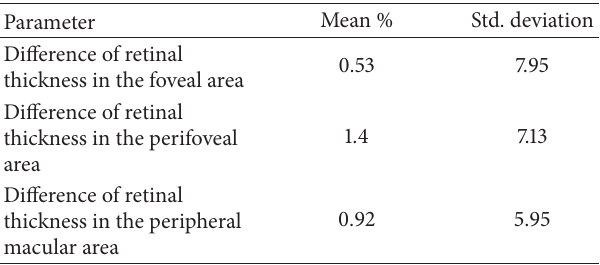
Table 2: Percent of change in retinal thicknesses before and after hemodialysisindiabeticretinopathypatientsindifferentpartsofthe